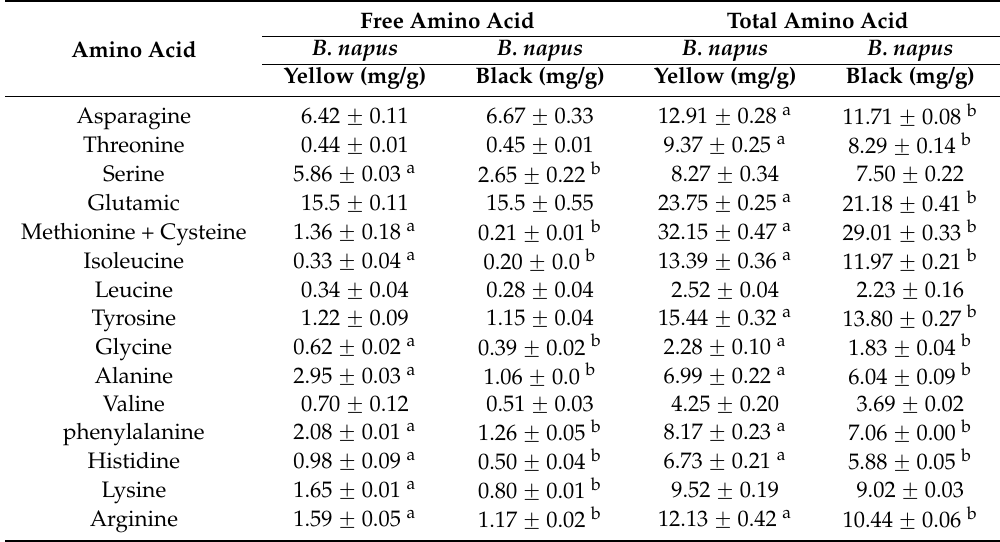
Table 2. Free and total amino acid composition of black- and yellow-seeded B. napus seed